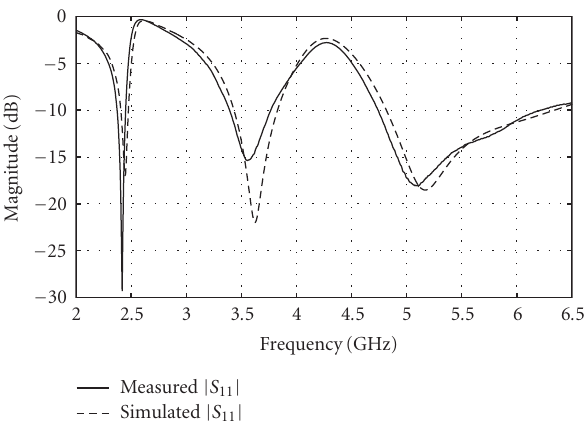
Figure 7: Simulated reflection coe ffi cient for di ff erent antenna heights.